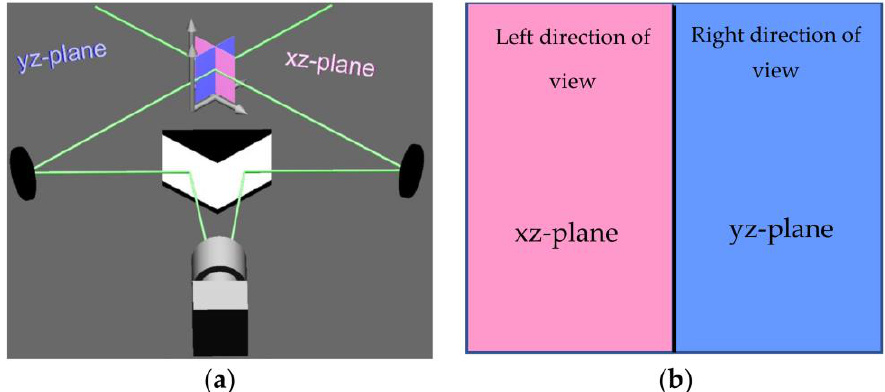
Figure 5. Schematic principle of the used stereo-optical measurement system: ( a ) schematic layout of camera and mirrors; ( b ) scheme of the divided CMOS camera chip.